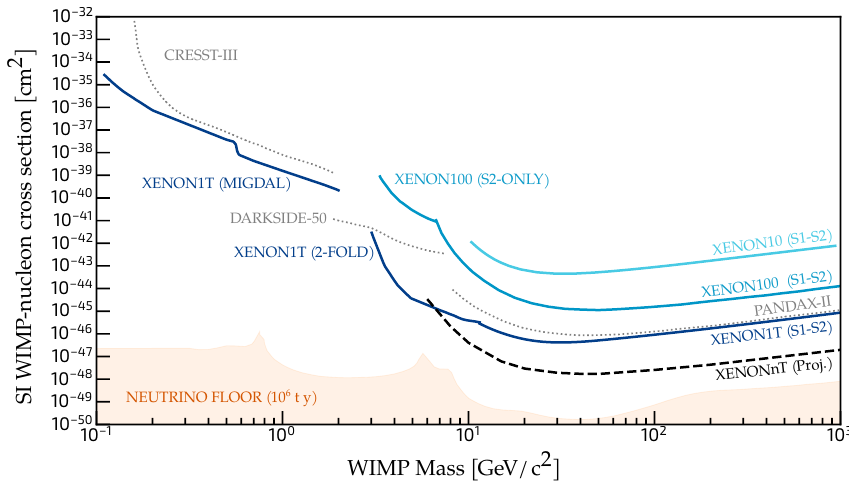
Figure 7. Best limits (90% confidence level) on the SI WIMP-nucleon cross section from the XENON experiments. At larger WIMP masses, standard DM searches based on both S 1 and S 2 signals are most sensitive. In order, XENON10 (2008) [120], cyan, XENON100 (2016) [121], azure, XENON1T (2018) [84], blue. The expected sensitivity of XENONnT [79] in the goal 20 t y exposure is shown as a black dashed line. All such analyses require a 3-fold PMT coincidence of the S 1 signals. Low- mass WIMPs ( (cid:46) 10 GeV/c 2 ) are probed by releasing the 3-fold requirement in order to lower the experimental energy threshold. Both XENON100 and XENON1T conducted data analyses exploiting only the S 2 signal. The S 2-only XENON100 (2016) result [122], azure, is combined with the S 1– S 2 limit in a unique line, where the kink indicates the transition of the best limit between the two different analyses. The XENON1T’s S 2-only limit (2019) [116] (not shown) was improved by an S 1– S 2 search with 2-fold S 1 coincidence requirement. The XENON1T 2-fold (2020) [119] curve is combined with the standard XENON1T’s result (blue). The XENON1T Migdal (2019) limit [108], blue, was obtained with a standard S 1– S 2 analysis looking for enhanced low-energy signals due to the Migdal effect. XENON1T’s results are currently the world-leading constraints in the WIMP mass range (0.1, 1000) GeV/c 2 , but between 2 and 3 GeV/c 2 where DarkSide-50 (2018) [123], a liquid Argon TPC at LNGS, set the best limit. The dotted grey line shows the combination of the current most stringent limits excluding XENON1T. At lower WIMP masses, CRESST-III (2019) [124] (a cryogenic scintillating calorimeter at LNGS) achieved the highest sensitivity. In the ( (cid:38) 10 GeV/c 2 ) WIMP mass regime, the exclusion limit by PANDAX-II (2017) [125] is very close to the result from LUX (2017 [126]), not shown for simplicity. Both detectors are LXe dual-phase TPCs as XENON experiments. The orange area shows the discovery limit of an idealized LXe experiment with the sole CE ν NS background and 10 6 t y exposure